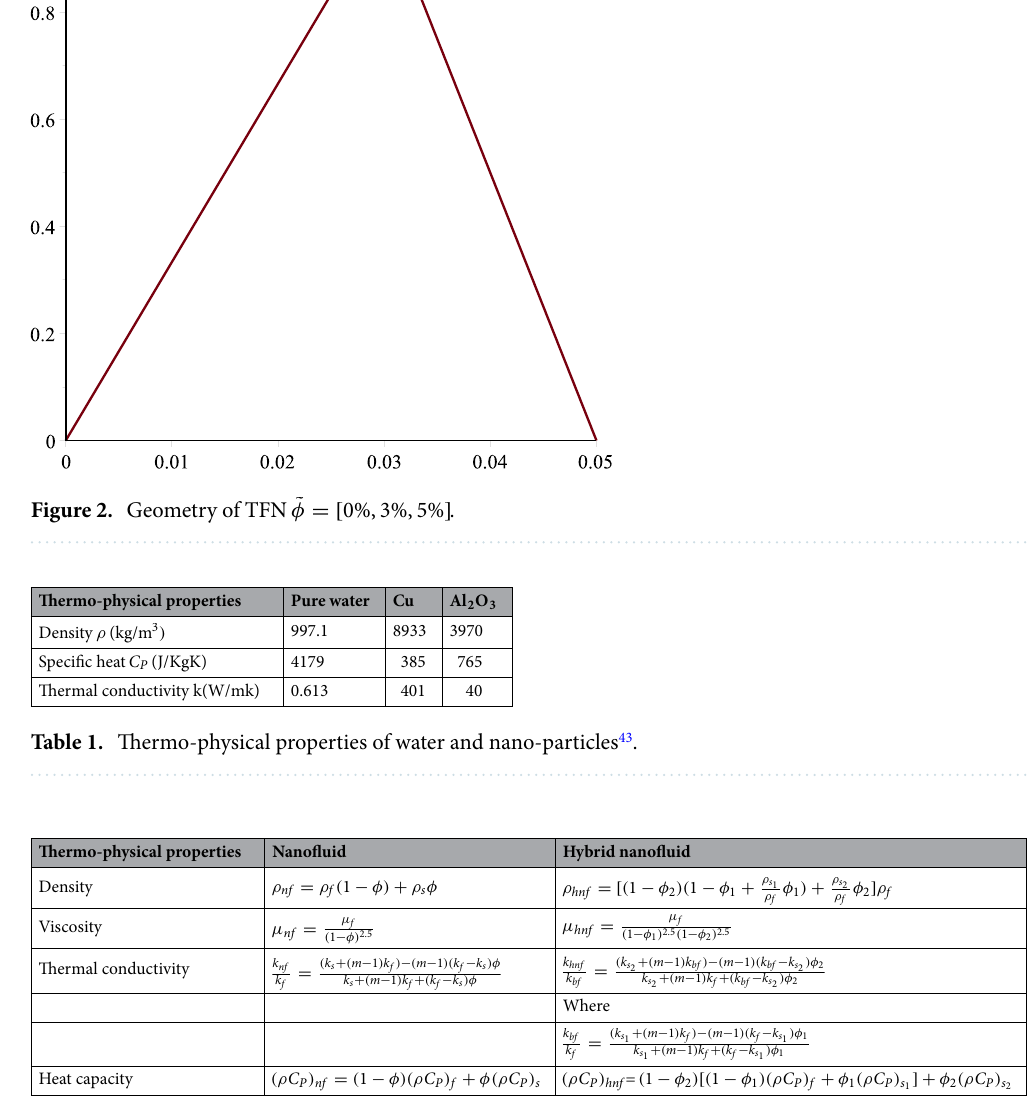
Table 2. The effective models of Hybrid nanofluid of physical parameters 42 .